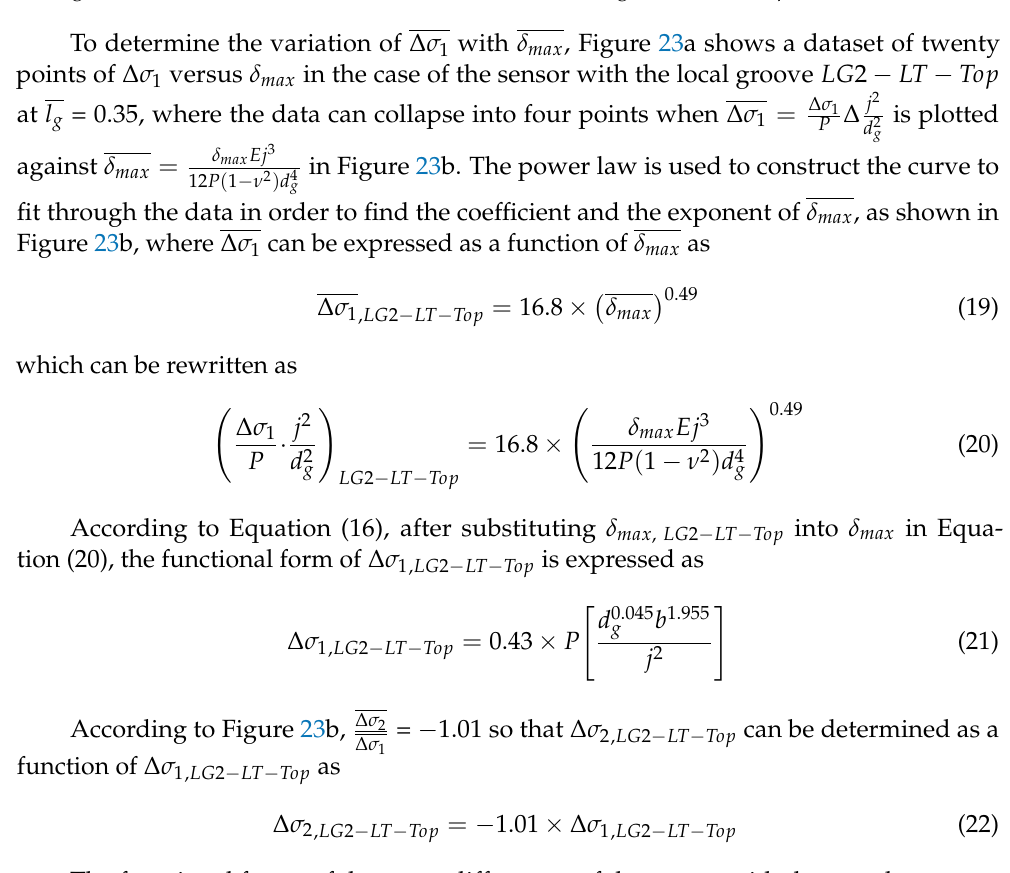
Figure 24. ( a ) Variations of averaged stress differences of longitudinal piezoresistor (∆𝜎 1 ) and transverse piezoresistor (∆𝜎 2 ) with maximum deflection ( 𝛿 𝑚𝑎𝑥 ) and ( b ) variations of dimensionless averaged stress differences of longitudinal piezoresistor ( ∆𝜎 1 ̅̅̅̅̅ ) and transverse piezoresistor ( ∆𝜎 2 ̅̅̅̅̅ ) with dimensionless maximum deflection (𝛿 𝑚𝑎𝑥 ̅̅̅̅̅̅̅) from two datasets (each with 20 points) in each averaged stress difference in the case of sensor with annular groove 𝐴𝐺 − 𝑇𝑜𝑝 .